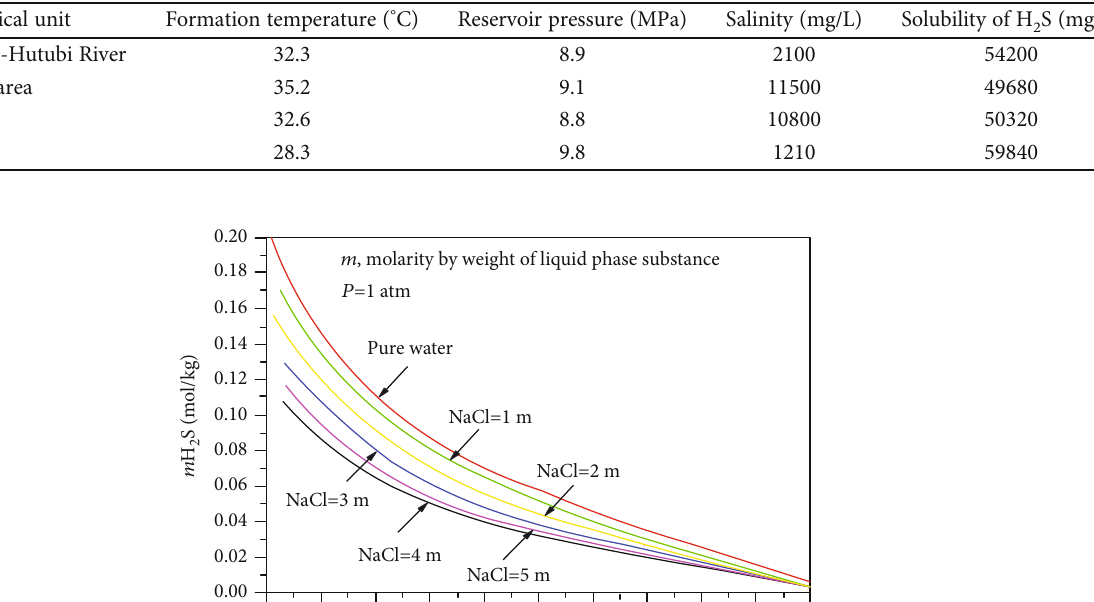
Table 2: Interaction parameters of H